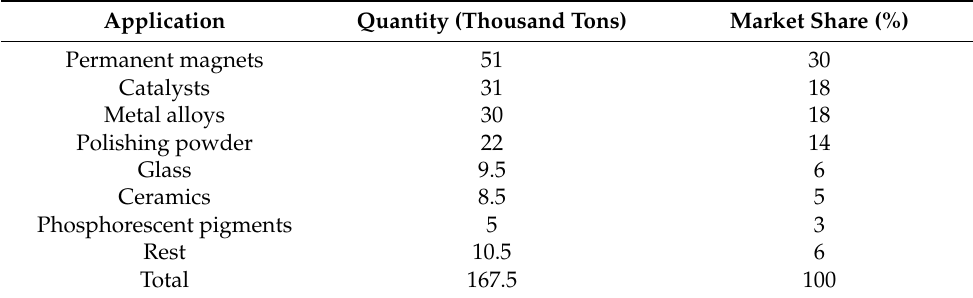
Table 1. Global requirements and application of Rare Earth